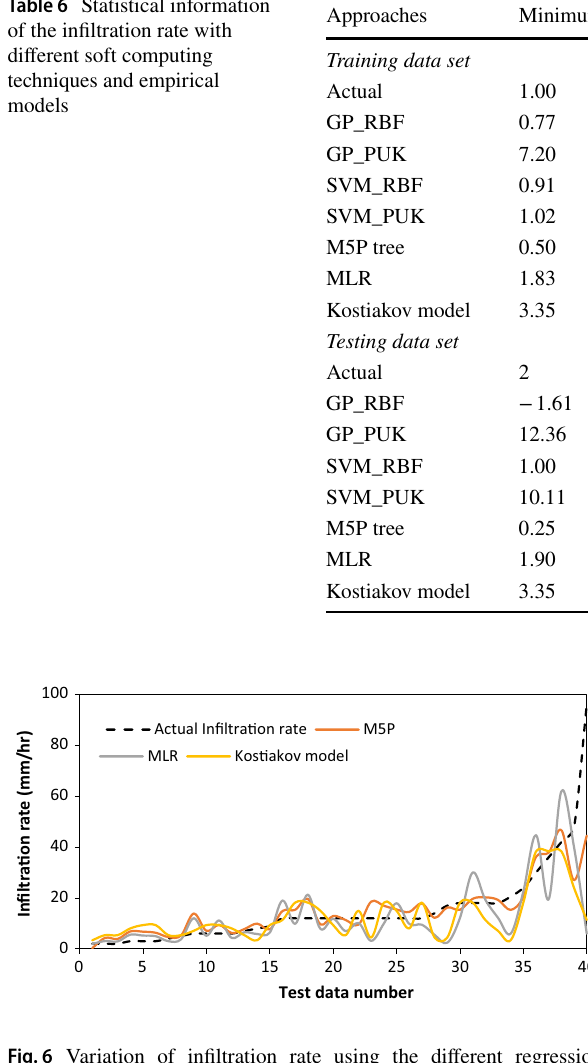
Fig. 6 Variation of infiltration rate using the different regression approaches